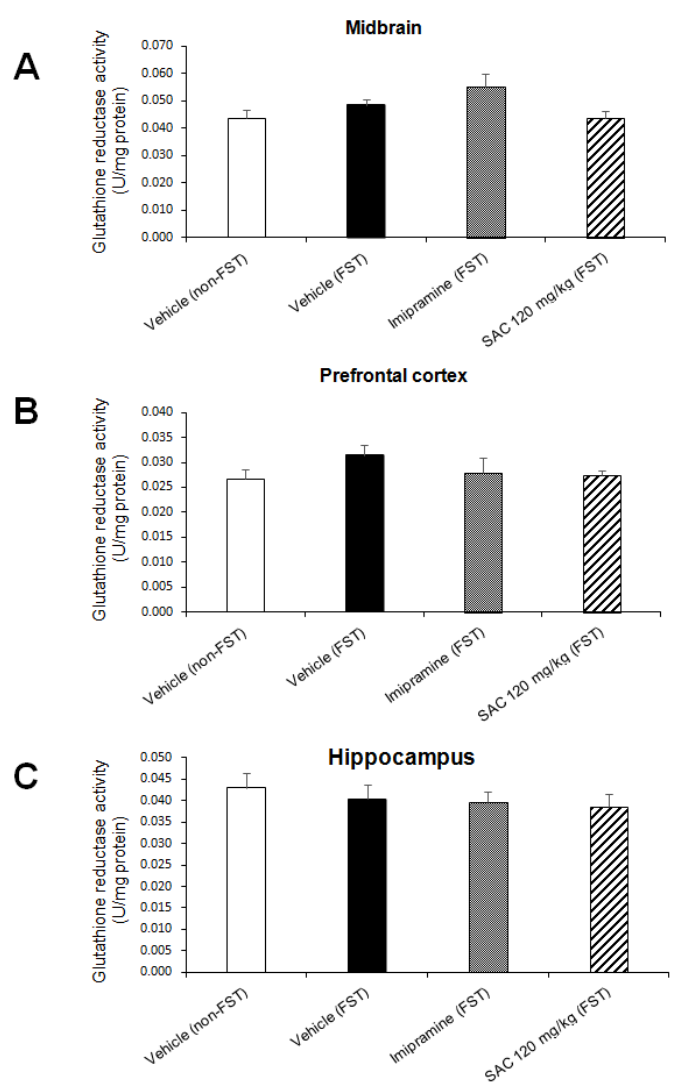
Figure 9. Effect of SAC on GR activity in different brain regions in mice exposed to FST. The vehicle (non-FST or FST), imipramine (FST) or SAC (120 mg/kg) were the treatment groups. SAC did not change GR activity in the midbrain ( A ), prefrontal cortex ( B ) or hippocampus ( C ) in FST vs. vehicle-FST group. Results are expressed as mean ± SEM of 7 – 9 animals per group. Results were analyzed using one-way ANOVA. FST = forced swimming test; SAC = S-allyl cysteine; GR = glutathione reductase.